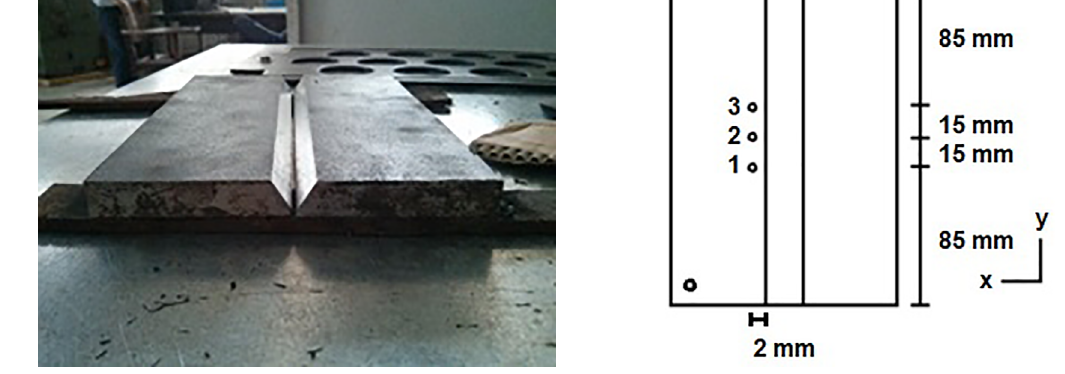
Figure 1. V-shaped chamfer with nose Figure 2. Distribution of the holes in the plate Table 2. Displacement of the coordinate points measured by the DCP. Welding speed